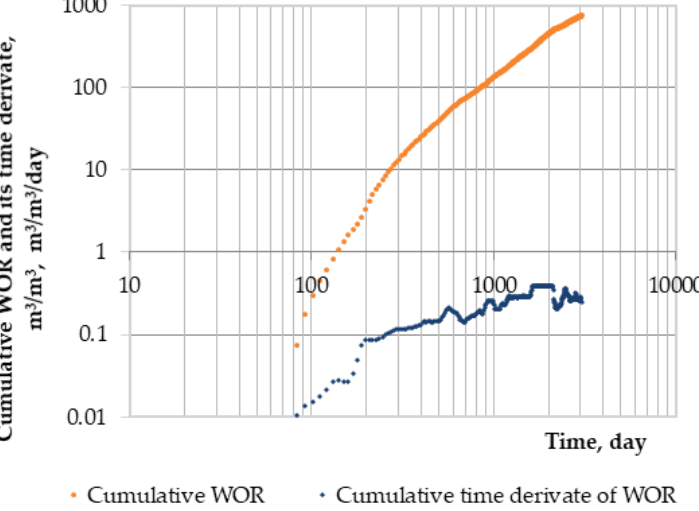
Figure 8. Diagnostic graphs in biologarithmic coordinates for the well No. 13G.